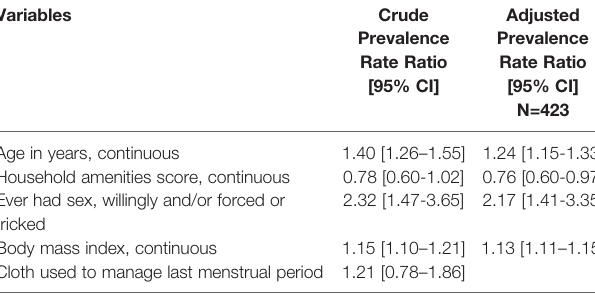
TABLE 5 | Results of poisson regression with robust variance estimate and random effect for school: crude and multivariable adjusted associations of sociodemographic and behavioral factors with bacterial